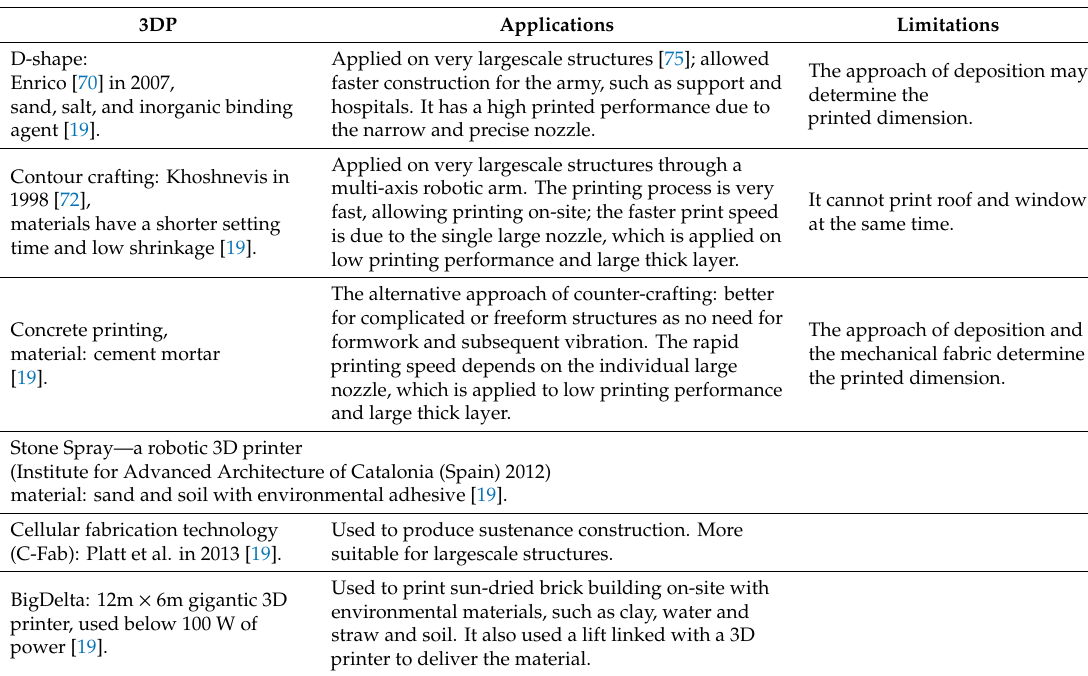
Table 6. Summary of largescale 3DPs used in the selected dataset of